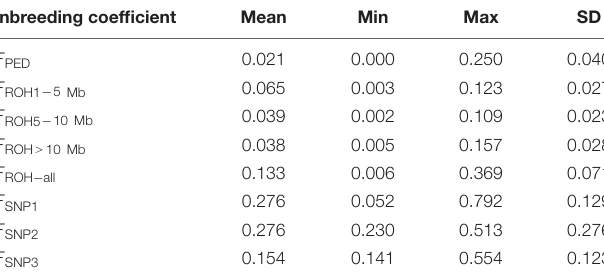
TABLE 1 | Descriptive statistics for the eight types of inbreeding coefficient estimates calculated from the pedigree ( F PED ), the identified ROH ( F ROH_all